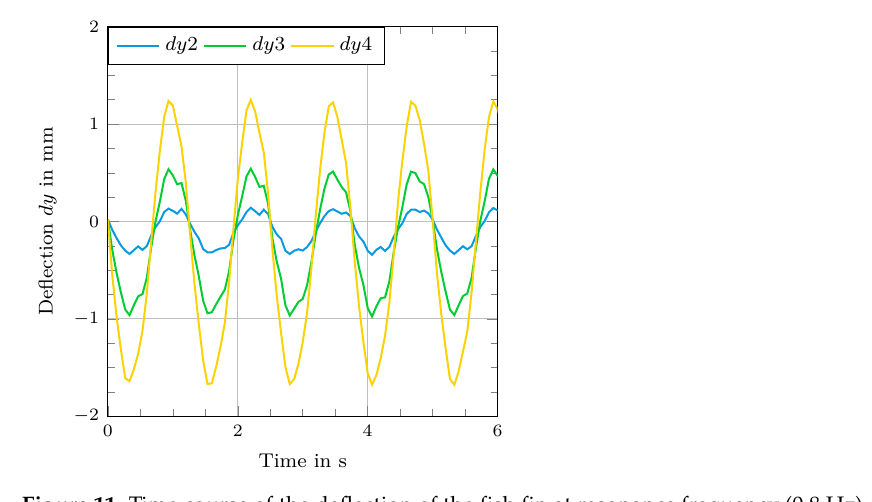
Figure 11. Time course of the deflection of the fish fin at resonance frequency (0.8 Hz) at the driving voltage of 3000